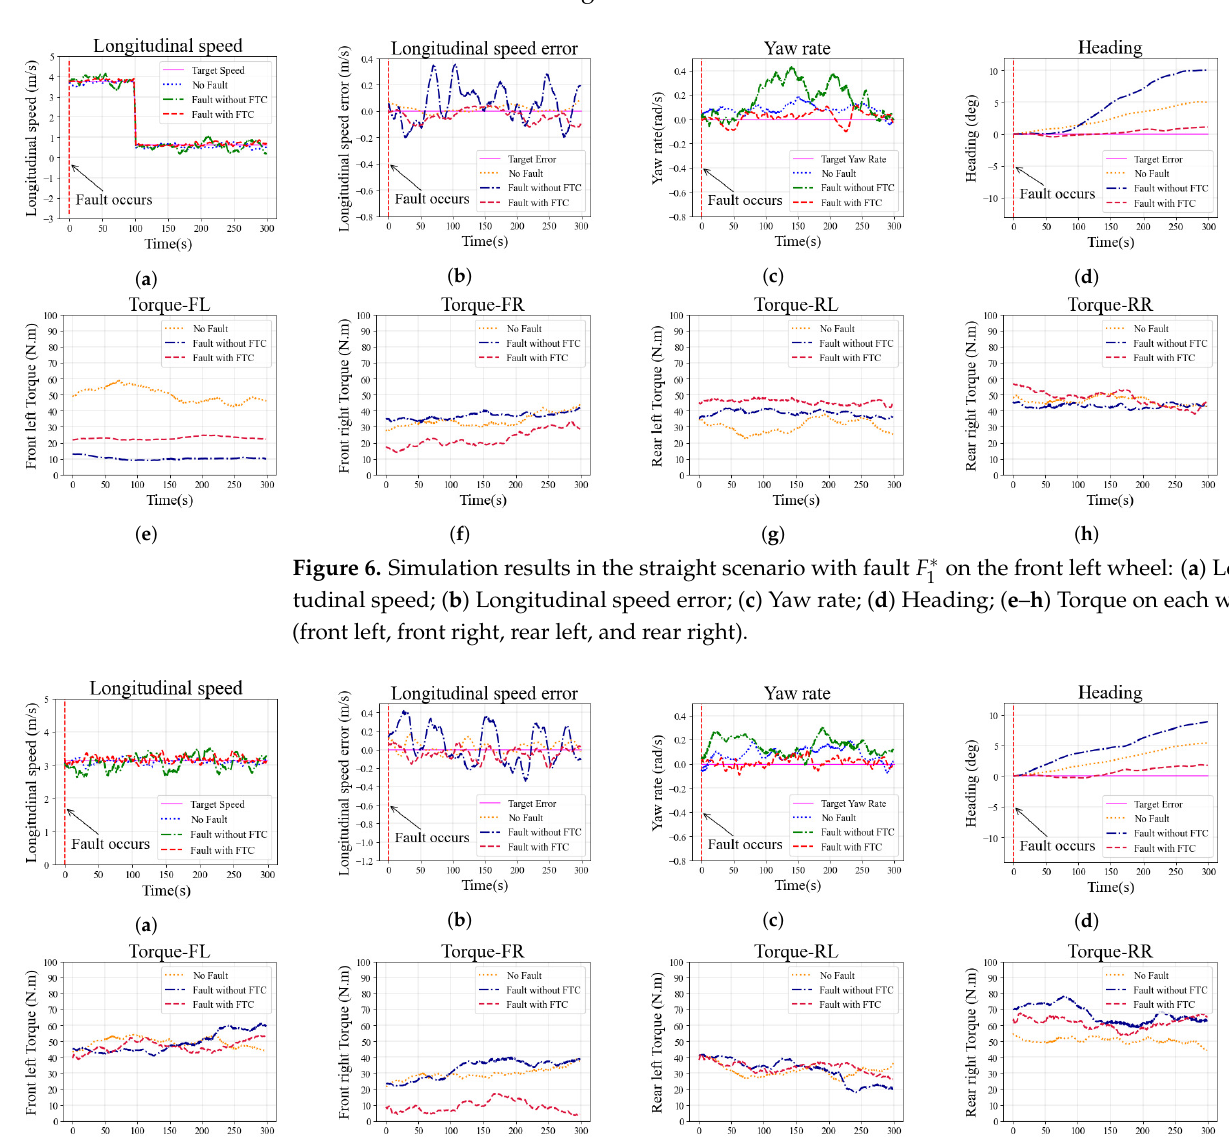
on the rear right wheel: ( a ) Longi- 2